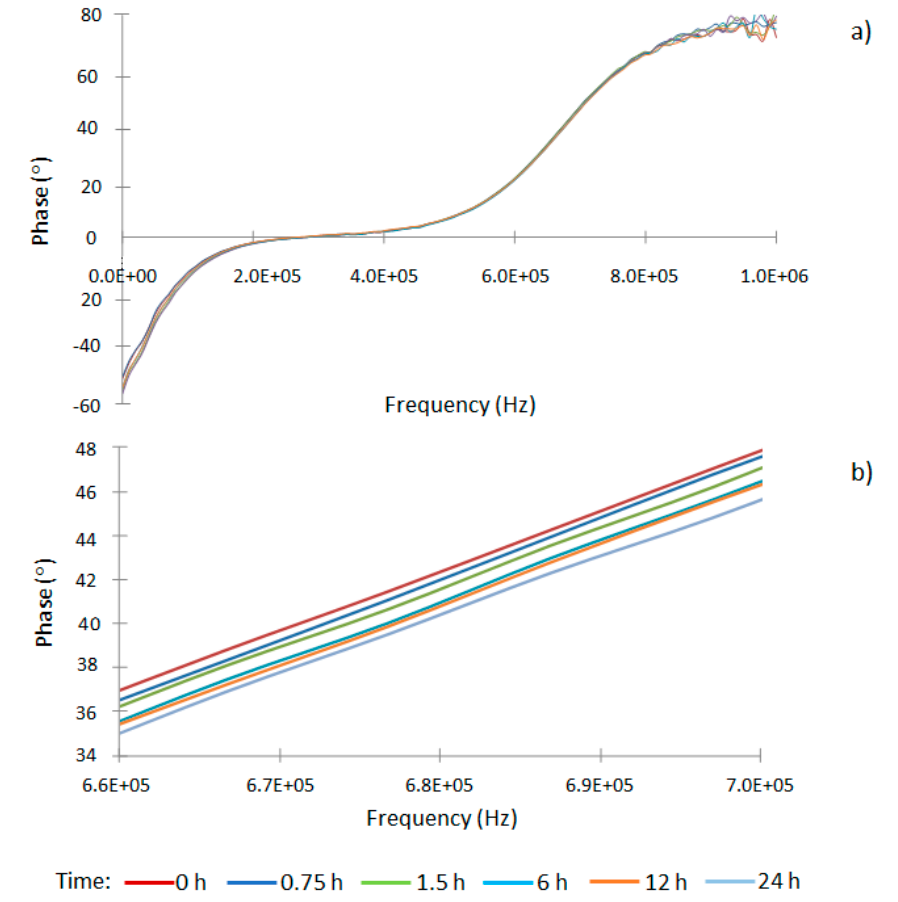
Figure 3. Phase data for pineapple waste saccharification at different time intervals (0 to 24 h) for ( a ) the complete analyzed frequency range; and ( b ) the studied frequency range (6.6 × 10 5 Hz–7.0 × 10 5 Hz).